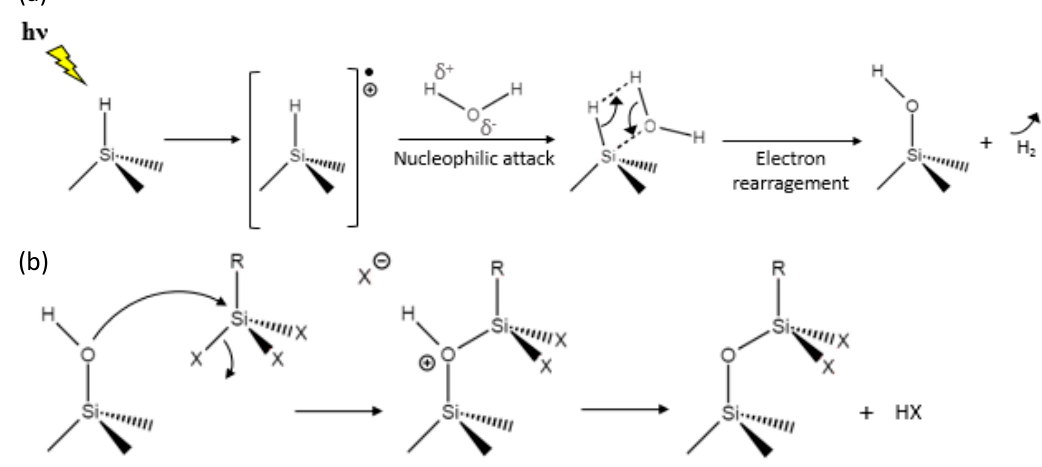
Figure 8. Proposed mechanism for the ( a ) visible light activation of PSi and ( b ) further condensation of the organosilanes on the hydroxylated PSi surface. X = OEt. R = –CH 2 CH 2 (CF 2 ) 7 CF 3 and –CH 2 CH 2 CH 2 NH 2 for PFDS and APTS, respectively.